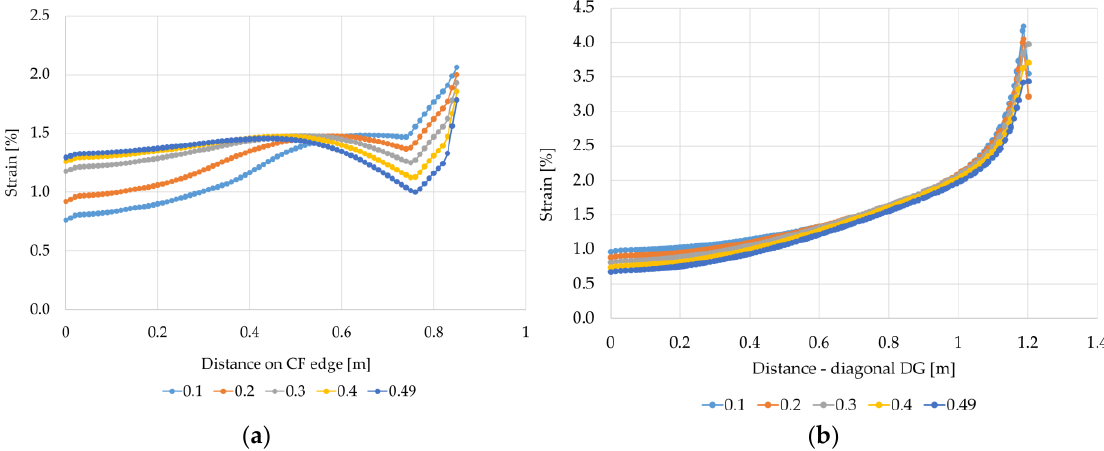
Figure 17. Charts of membrane strains depending on the Poisson’s ratio value—variant A2: ( a ) the edge CF, ( b ) the diagonal DG.